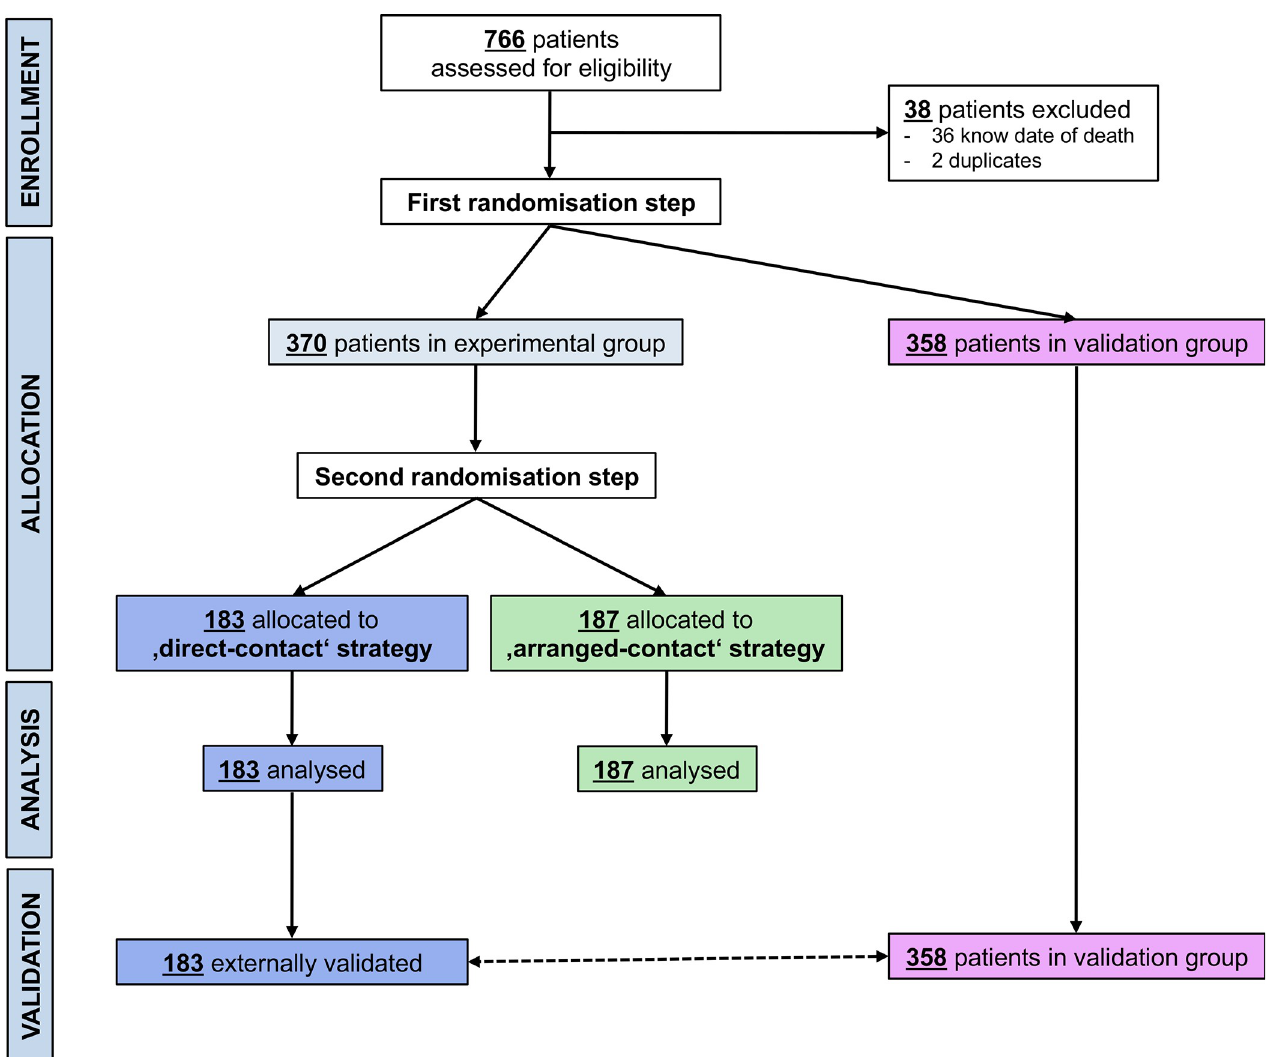
Fig 2. CONSORT diagram. The CONSORT diagram shows the patient flow through the study including trial and external